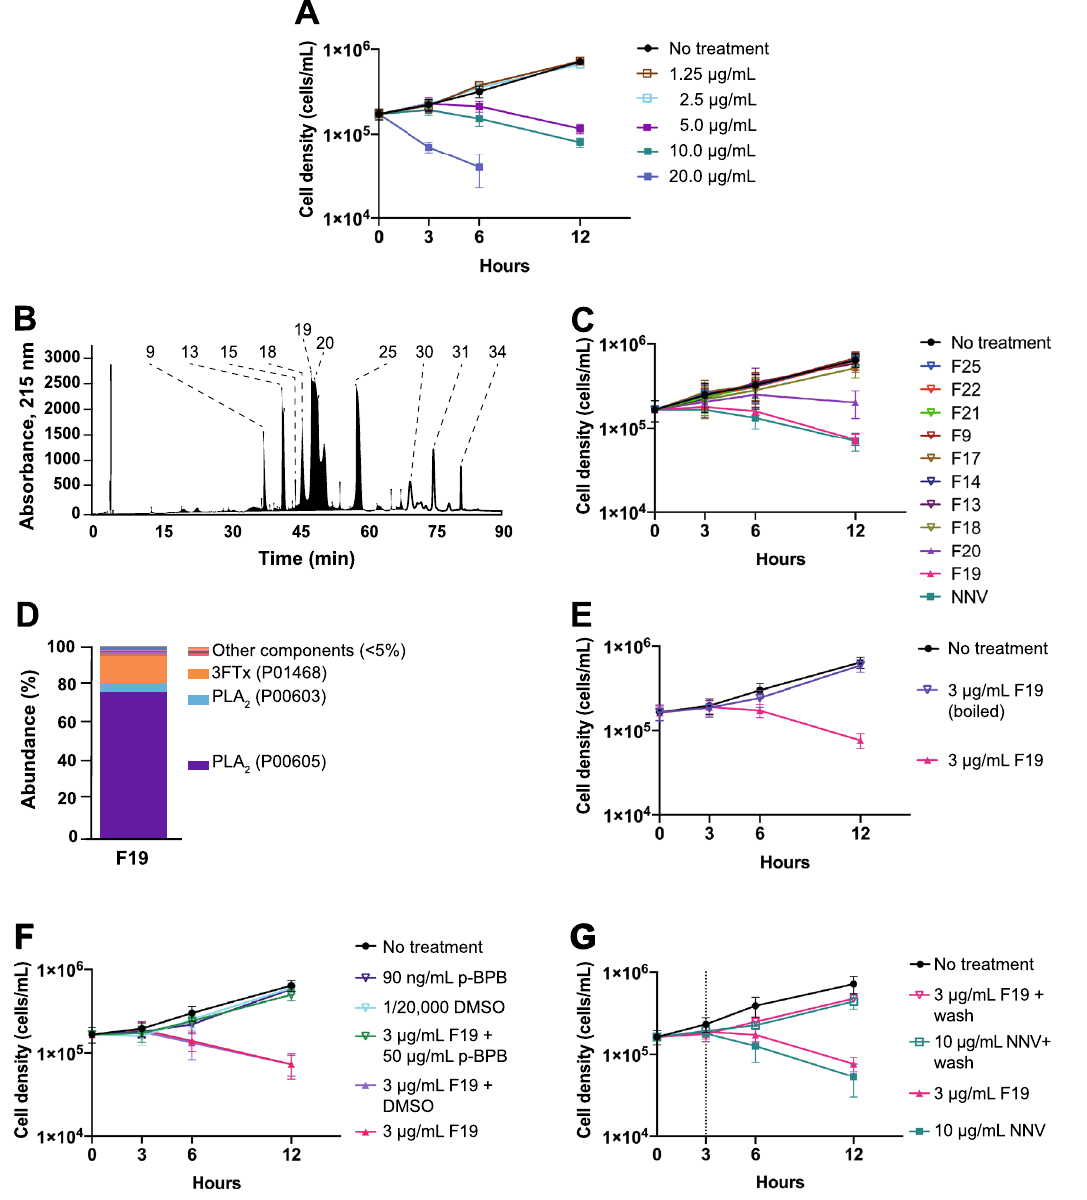
Figure 2. N. nigricollis PLA 2 s seem to be the necessary and sufficient venom components to induce trypanocidal activity. ( A ) N. nigricollis venom (NNV) causes rapid T. brucei death. 20 μg/mL NNV kills the entire population of T. brucei within 8 h. 5 μg/mL NNV was the minimum effective concentration able to kill the cell population within 24 h. ( B ) NNV chromatogram. NNV was fractionated by RP-HPLC. ( C ) Fractions containing PLA 2 s retain trypanocidal activity, showing that PLA 2 s are likely the necessary components to induce cell death. Fraction 19 containing PLA 2 s and the juxtaposed fraction 20, also containing PLA 2 s, retained trypanocidal activity upon venom fractionation. Venom fractions were tested at 3 μg/mL. NNV was tested at 10 μg/mL. ( D ) Fractions retaining lethal effects contain PLA 2 s. LC–MS analysis of fraction 19. The relative abundance of PLA 2 s in fraction 19 is 83%. ( E ) PLA 2 s require tertiary structure to exert their observed trypanocidal activity. 3 μg/mL. Fraction 19 was incubated at 100 ºC for 5 min and then further incubated for 12 h with cultures of T. brucei VSG121 wild type. Boiled fraction 19 imperiled trypanocidal activity. ( F )